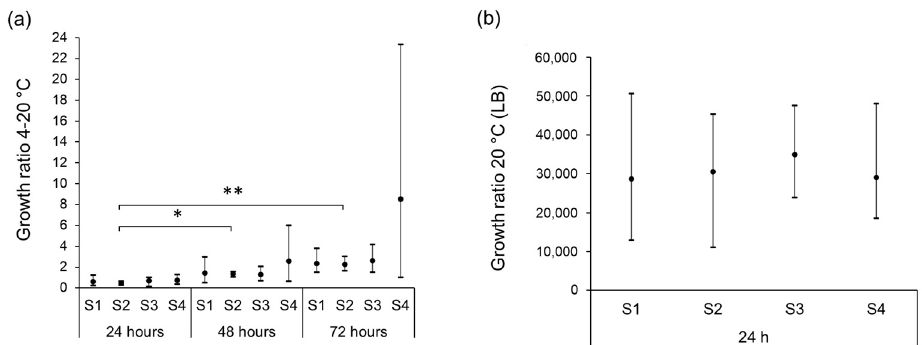
Figure 4. Chart showing the minimum, maximum, and average of growth ratios for STEC isolates S1, S2, S3, and S4 in unpasteurized milk at 4 ◦ C under a temperature abuse scheme of 90 min at 20 ◦ C every 24 h ( a ) and at 20 ◦ C in LB-broth ( b ). Asterisks represent statistical differences from pairwise comparisons determined using two-tailed paired Student’s t tests (* p < 0.01; ** p < 0.05). Recordings of the temperature fluctuation in the 40 mL raw milk showed that after reaching 20 ◦ C, it took >3 h for the milk to reach below 5 ◦ C (Figure 5).